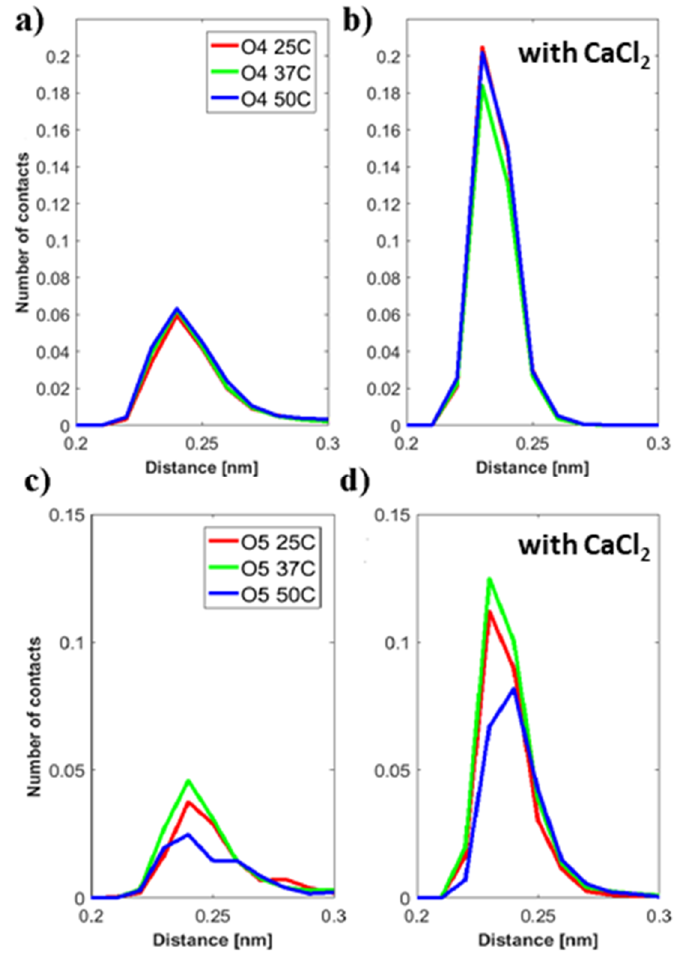
Figure 12. Distribution of distances between DPPC-O4 atom class and: ( a ) sodium ions, ( b ) calcium ions. Distribution of distances between: ( c ) sodium ions, ( d ) calcium ions and the HA-O5 atom class.